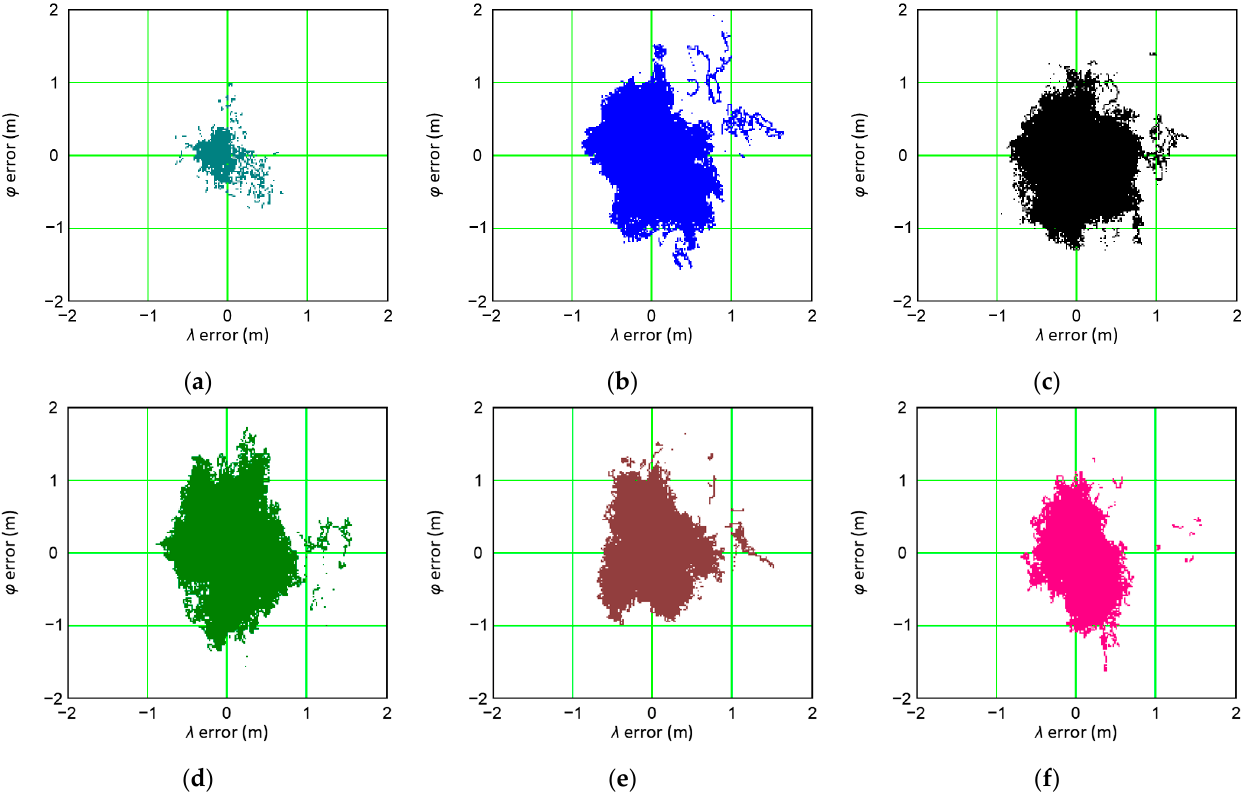
Figure 6. The distributions of the DGPS system’s errors containing the same HDOP value: 0.8 ( a ), 0.9 ( b ), 1.0 ( c ), 1.1 ( d ), 1.2 ( e ), and 1.3 ( f